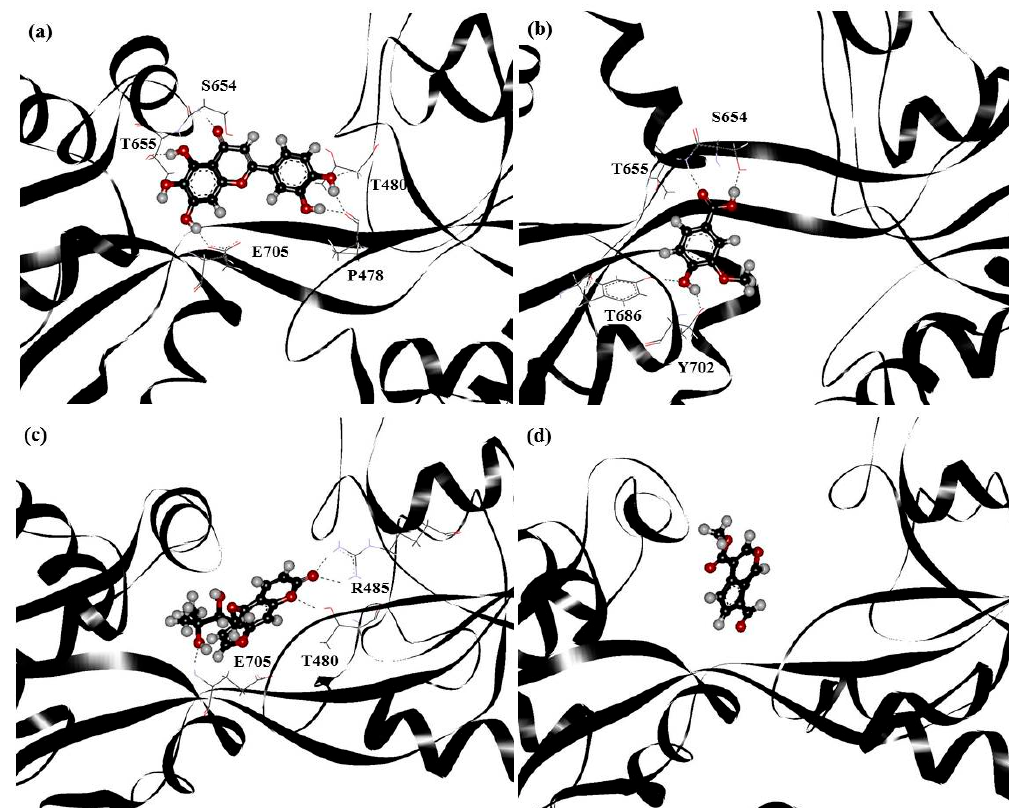
Figure 5. The snapshot of molecular dynamics simulation in ( a ) PHF; ( b ) HMB; ( c ) DHMBP; ( d ) cerbinal systems. The red, black and grey balls represent oxygen, carbon and hydrogen atoms. The black line represents backbone of GluR2.